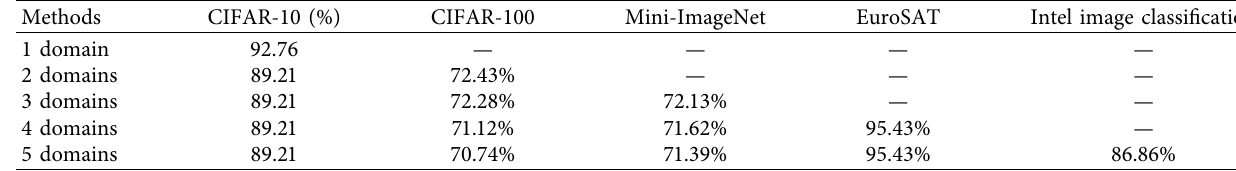
Table 3: Evaluation of domain scalability based on CDCL.